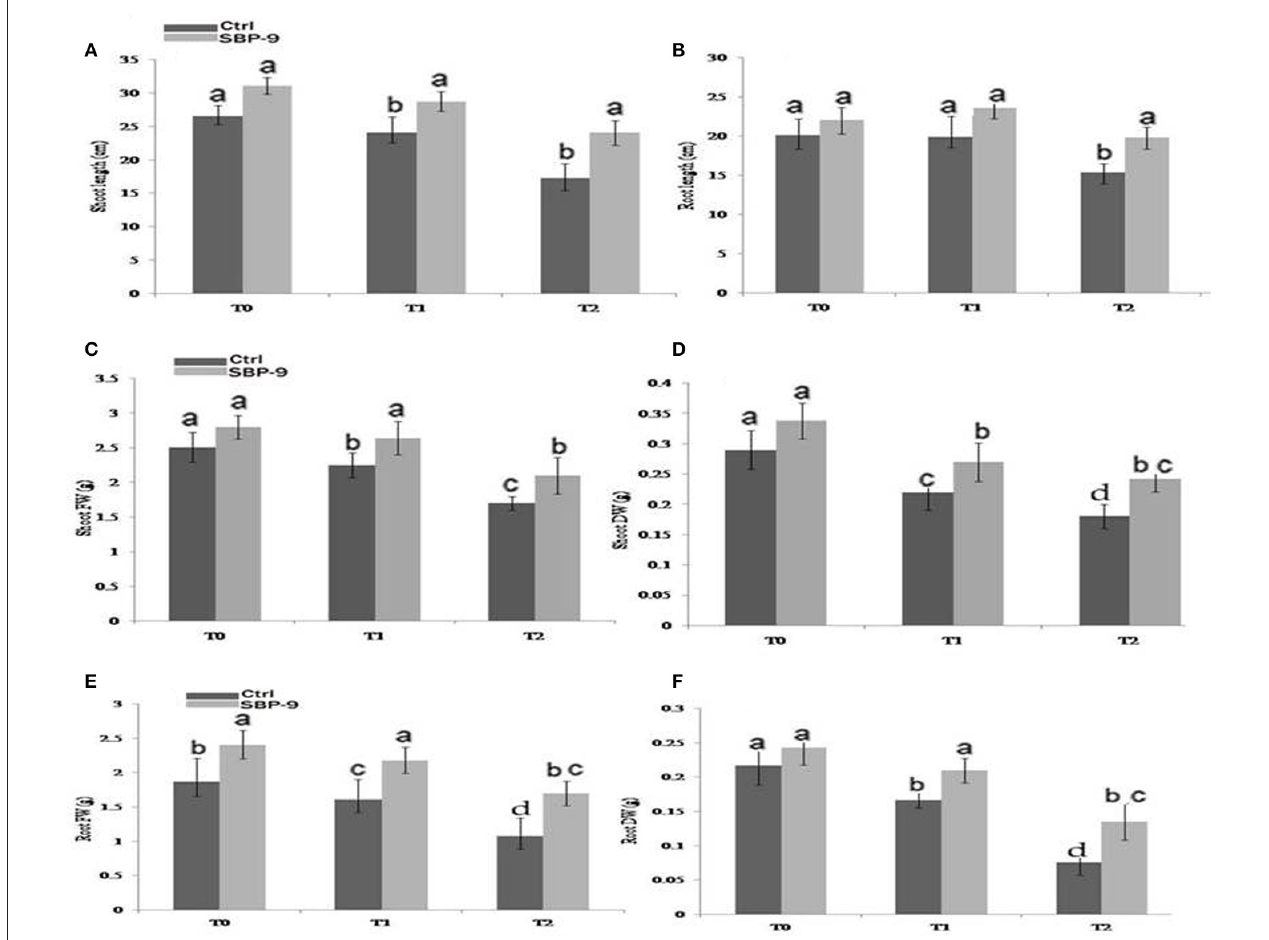
FIGURE 2 | Effect of inoculation of isolate SBP-9 on plant growth and biomass content under different treatments T-0 (0mM NaCl), T-1 (150mM NaCl), T-2 (200mM NaCl); (A) Shoot length (B) Root length (C) Shoot fresh weight (D) Shoot dry weight (E) Root fresh weight (F) Root dry weight. Each data represent the mean ± SD of triplicate sets of five measurements ( n = 15). Different letters on the bar in each column represent the significant